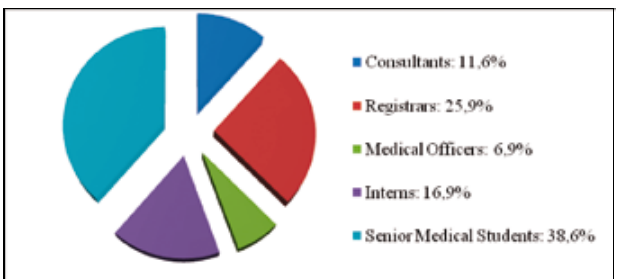
Fig. 2. Post descriptions of clinicians participating in the study.